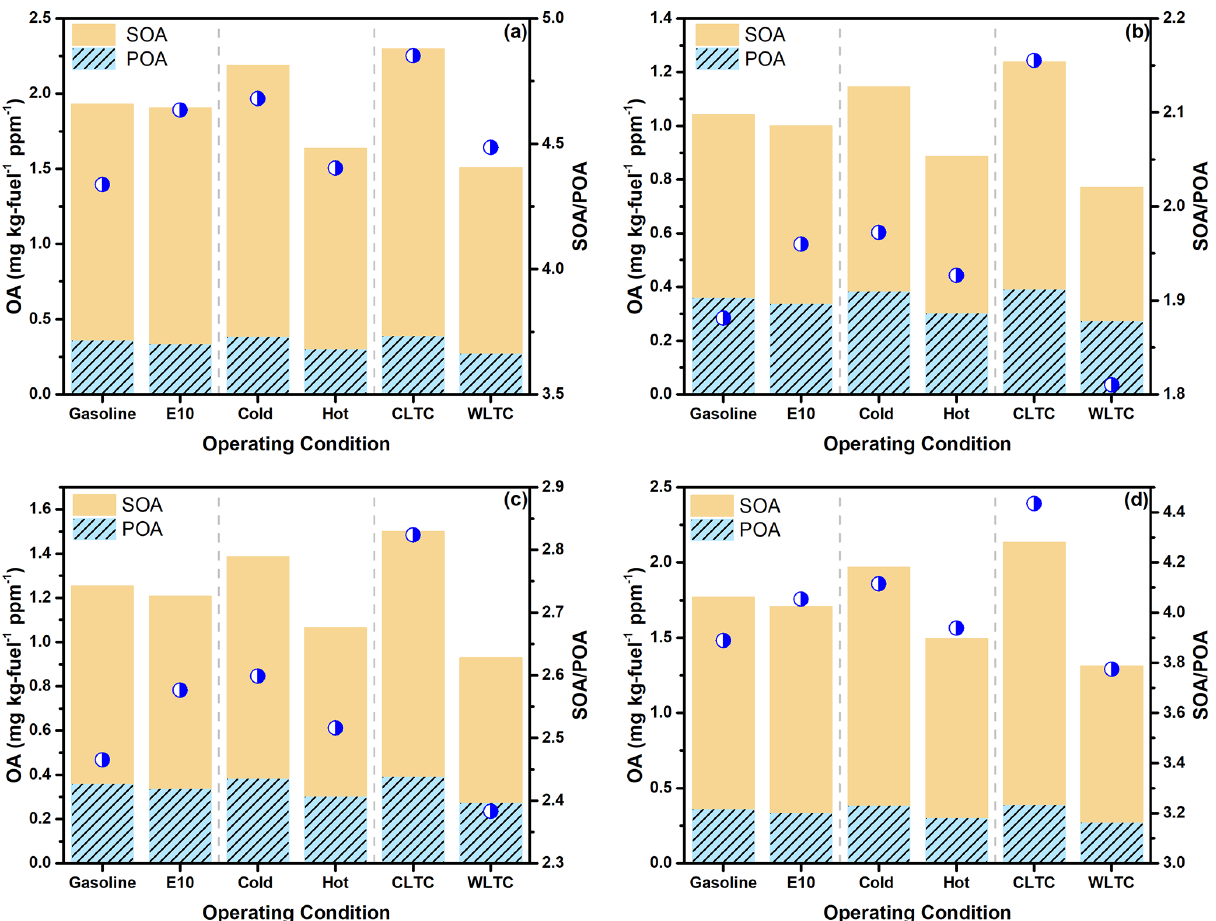
Figure 5. Comparison of POA and estimated SOA production after 48h of photo-oxidation (a) under low-NO x conditions, (b) at an OA loading of 10µgm − 3 under high-NO x conditions, (c) at an OA loading of 20µgm − 3 under high-NO x conditions and (d) at an OA loading of 80µgm − 3 under high-NO x conditions. The blue circles represent the SOA-to-POA ratio after 48h of photo-oxidation (right